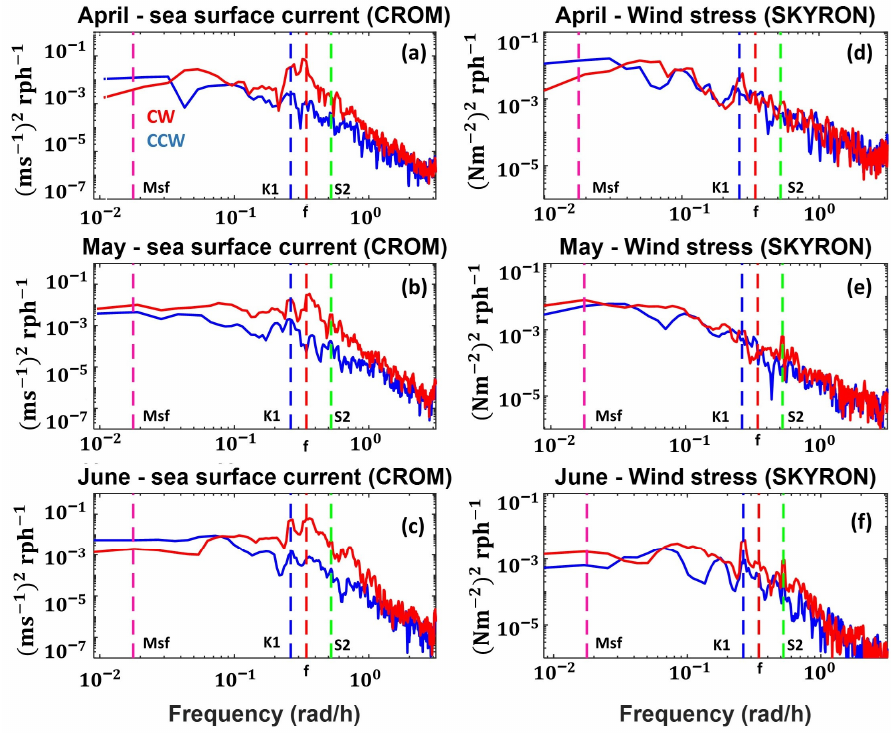
Figure 12. Clockwise (red) and counterclockwise (blue) spectra for modeled hourly surface currents and Skyron wind stress data for April ( a , d ), May ( b , e ) and June ( c , f ). The tidal constituents (K1: blue vertical dashed line; S2: green vertical dashed line; f: red vertical dashed line; Msf: violet vertical dashed line) are evidenced on the frequency axis. Table 13. Tidal ellipse parameters (major and minor axes, inclination and phase) together with 95% confidence levels (Emaj, Emin, Einc, Epha) for the tidal constituents with SNR greater than 2. (a), (b) and (c) refer to surface current in April, May and June, respectively. (d), (e) and (f) refer to wind stress for April, May and